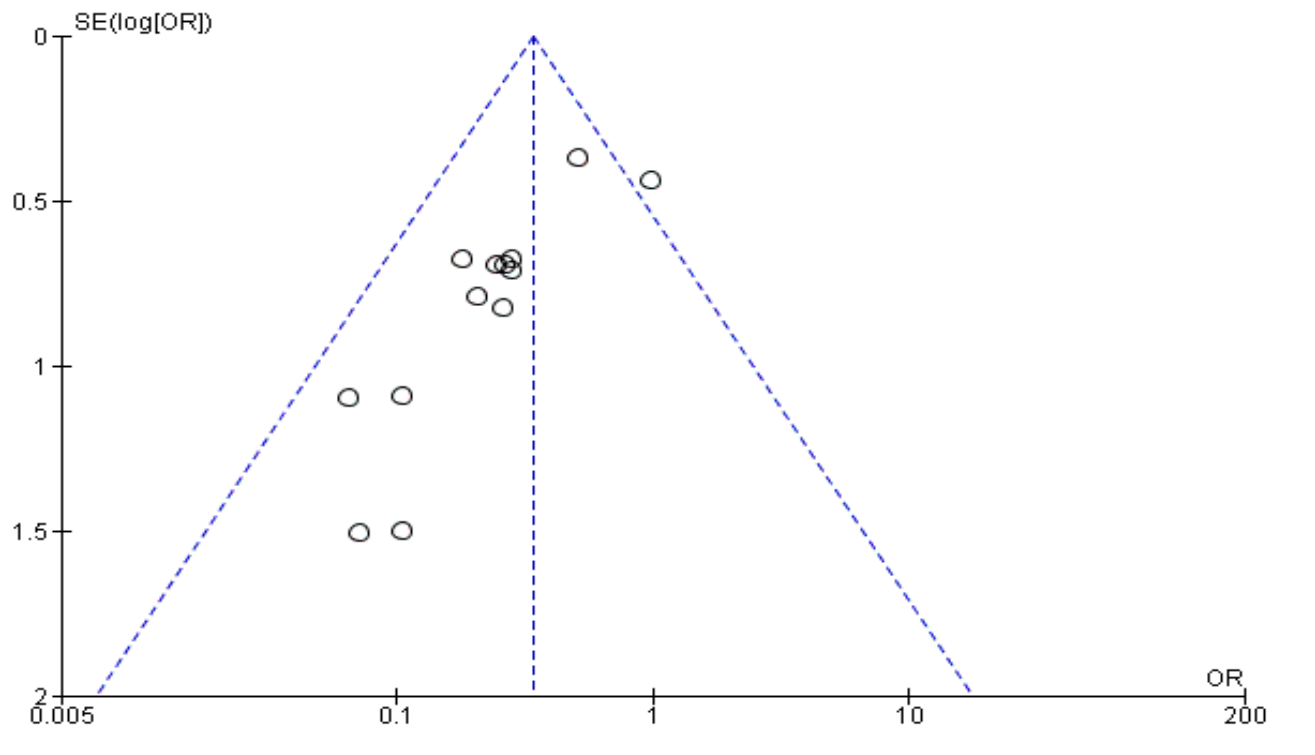
Figure 6. Funnel plot of the studies included in the analysis of the metastatic lymph nodes harvested.